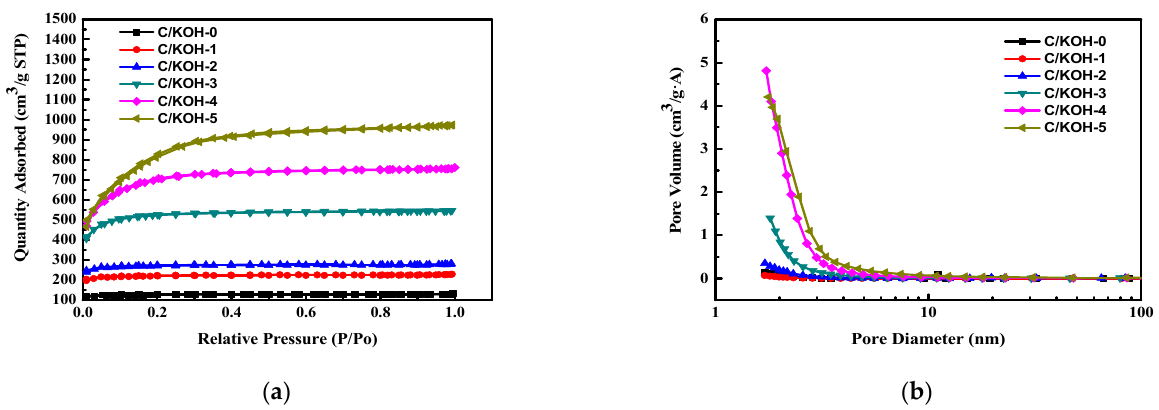
Figure 2. Nitrogen adsorption and desorption curves of the undoped activated carbon powders ( a ) and pore size distribution curves of different undoped activated carbons ( b ).